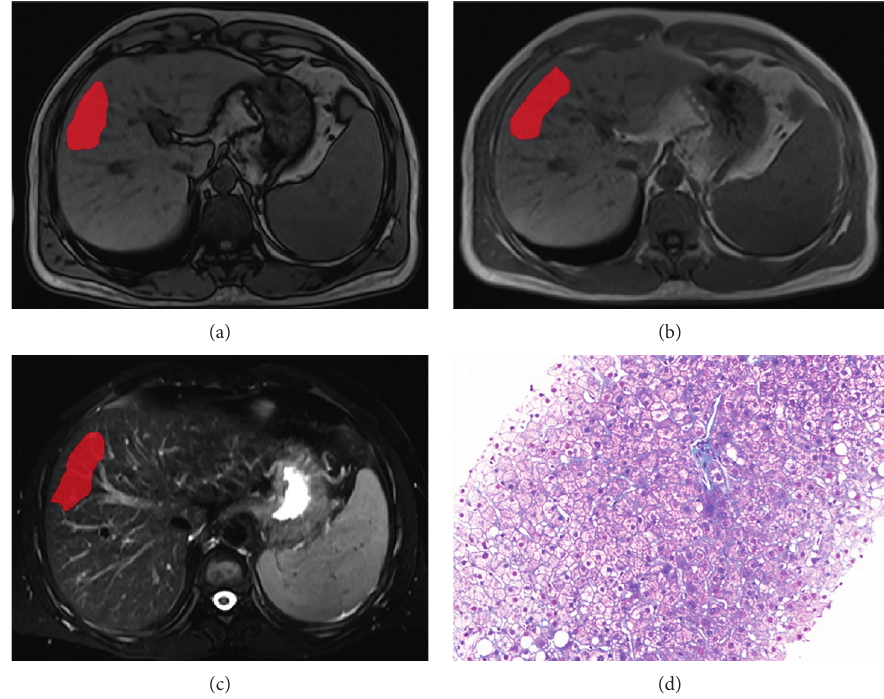
Figure 2: A 40-year-old man with hepatitis B infection. (a–c) ROI delineated using ITK-SNAP on out-of-phase T1W, in-phase T1W, and T2W images. (d) Histopathological features obtained from liver biopsy revealed stage 2 fibrosis. The patient was classified in significant fibrosis by the final